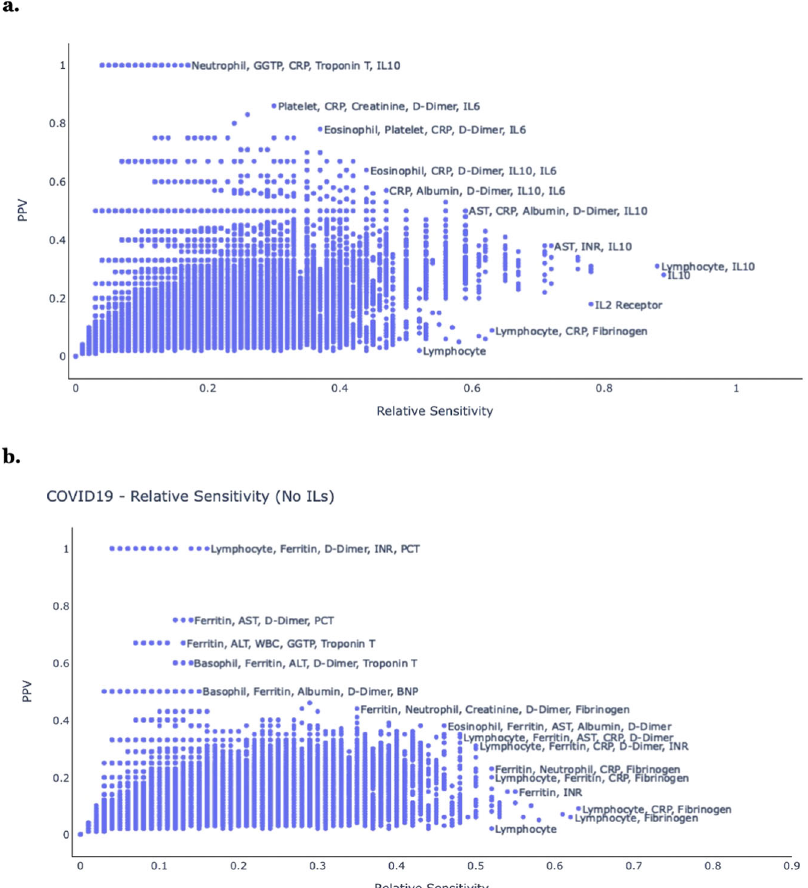
Fig. 5 Individual approach, SARS-CoV-2. Comparison of different laboratory test combinations, according to the relative sensitivity (X-axis) and the PPV (Y-axis) for association with SARS-Cov-2 infection status. Results are shown a with IL tests and b without IL